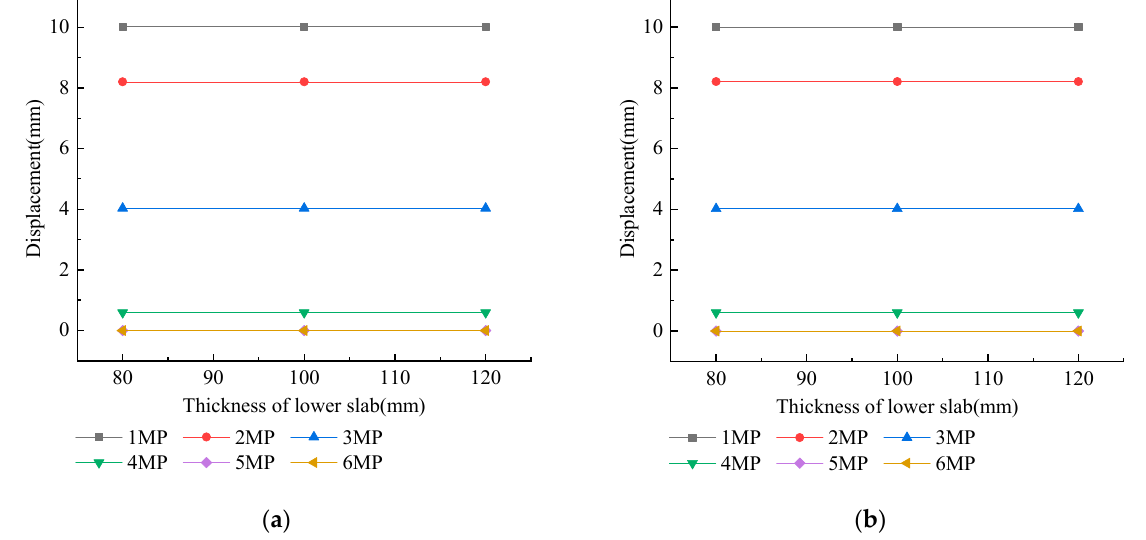
Figure 14. The vertical displacement trend of the bottom of the cast-in-place layer under different lower slab thickness conditions during the running period. ( a ) Rail seats and ( b ) cast-in-place con- crete.